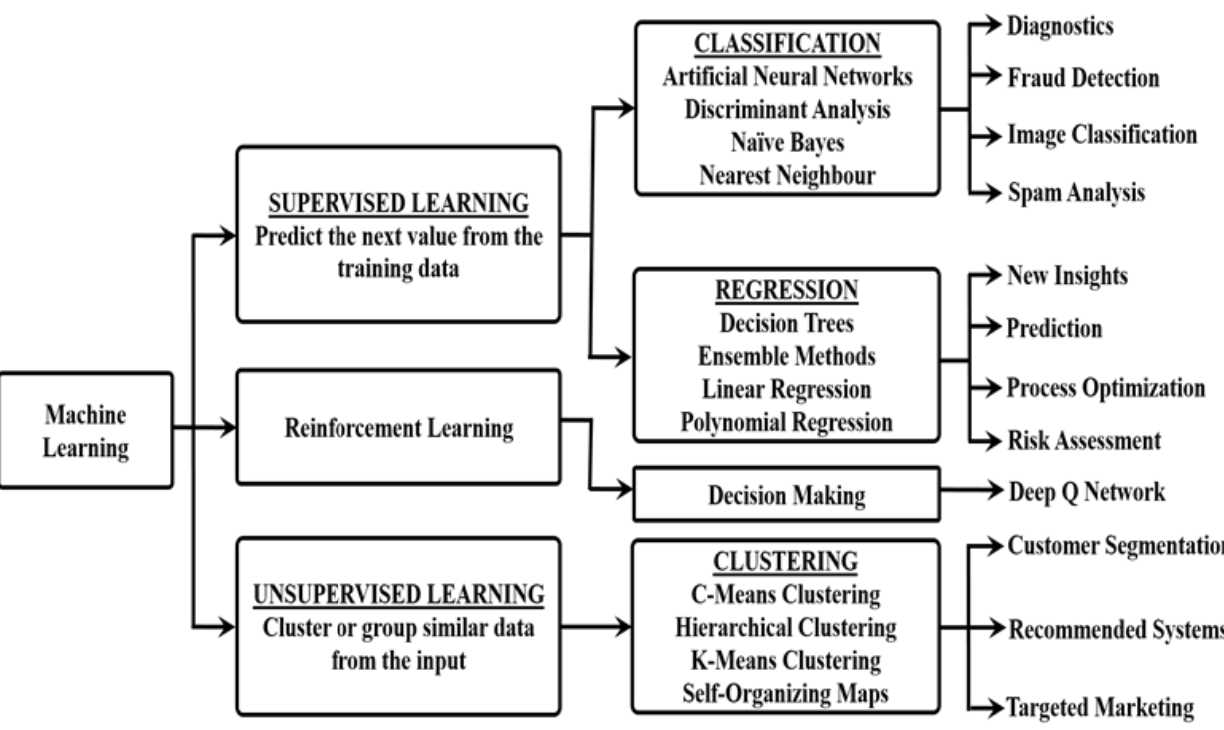
Figure 8. Classification of ML techniques into various sub-categories